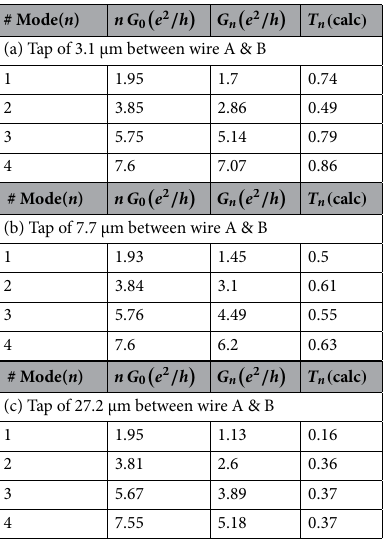
Table 1. Transmission probability of the first four modes, calculated with the Landauer formula, from the measured conductance trough wire A and B tuned to the same mode, separated by taps of various widths: ( a )